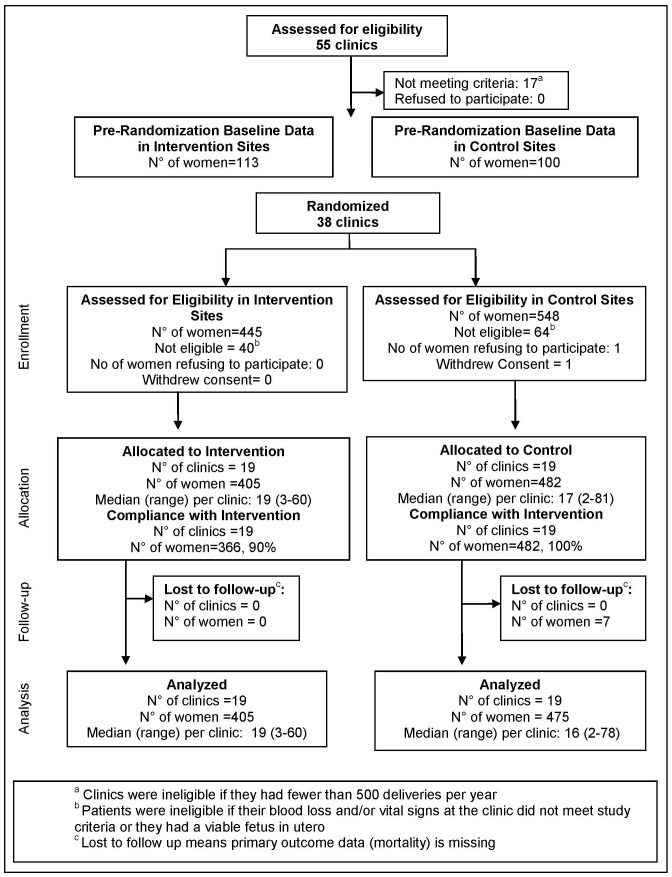
Cluster Randomized Trial Design.